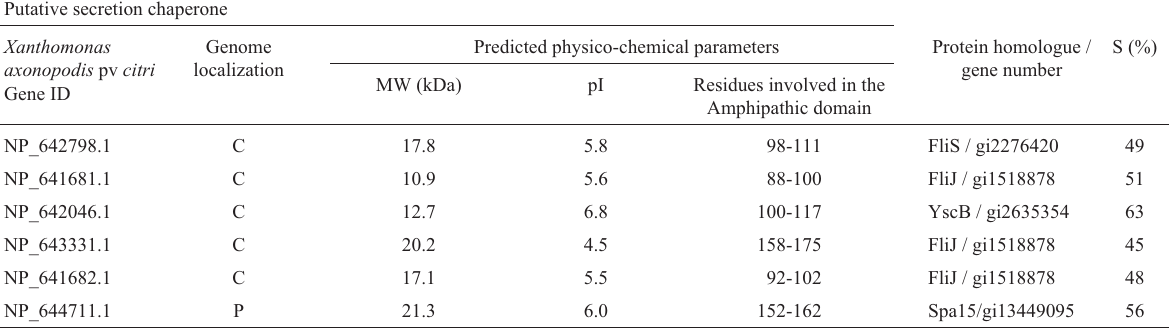
Table 1 - Potential type III chaperone genes identified by sequence homology and predicted protein physico-chemical characteristics. The Xanthomonas axonopodis pv citri genomewassearchedforhomologytotypeIIIchaperones.Fiveoftheidentifiedgenesarelocalizedinthechromosomeandoneinthe plasmid pXAC33 (da Silva et al. , 2002). All 6 were confirmed for type III chaperone characteristics as described in Material and Methods. This method allowed the identification of genes with 45% (or higher) homology to type III and flagellar chaperones. Putative secretion chaperone Xanthomonas Genome axonopodis pv citri